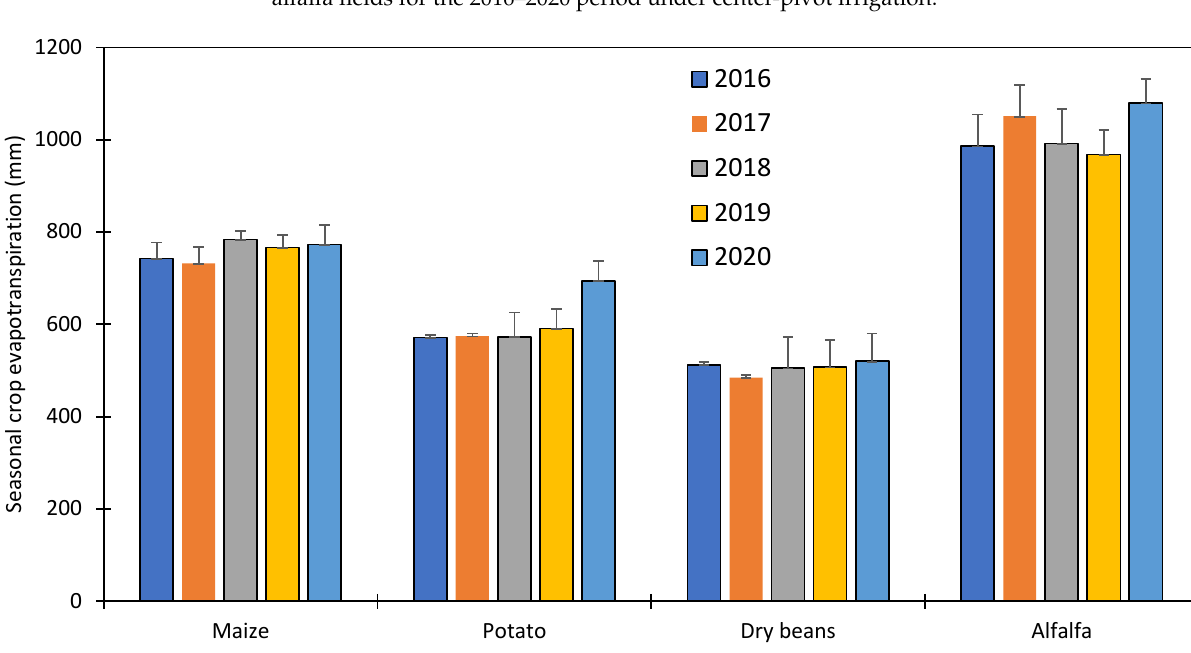
Figure 9. Seasonal crop evapotranspiration (mm) of maize, potatoes, dry beans, and alfalfa for the 2016 – 2020 period.